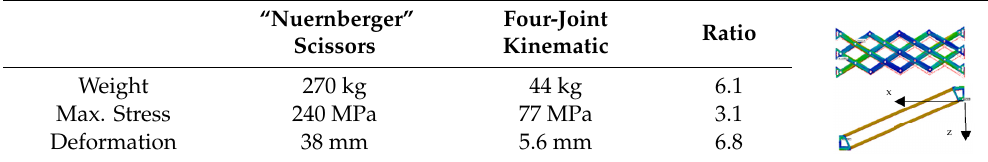
Table 1. Finite element method for the two cross-connection concepts.